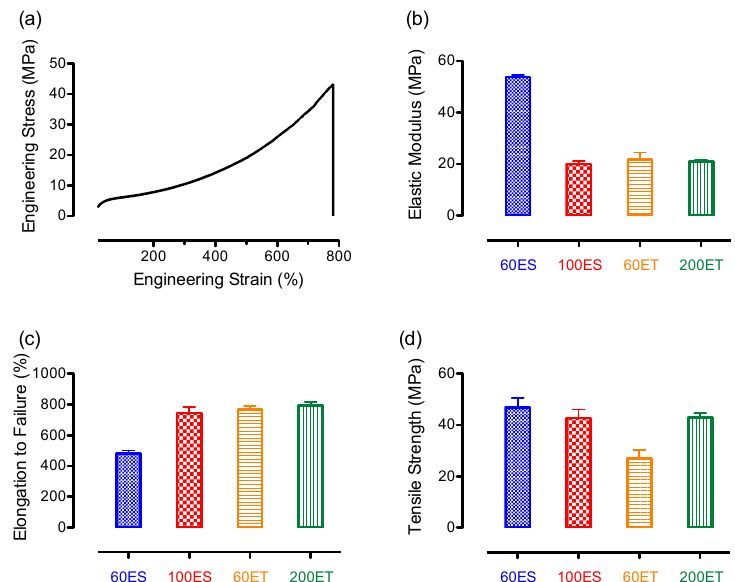
Figure 7. Mechanical properties of the various PU films, showing ( a ) a representative engineering stress-strain curve from 200ET groups; ( b ) average elastic moduli; ( c ) average elongation to failure; and ( d ) average tensile strength.